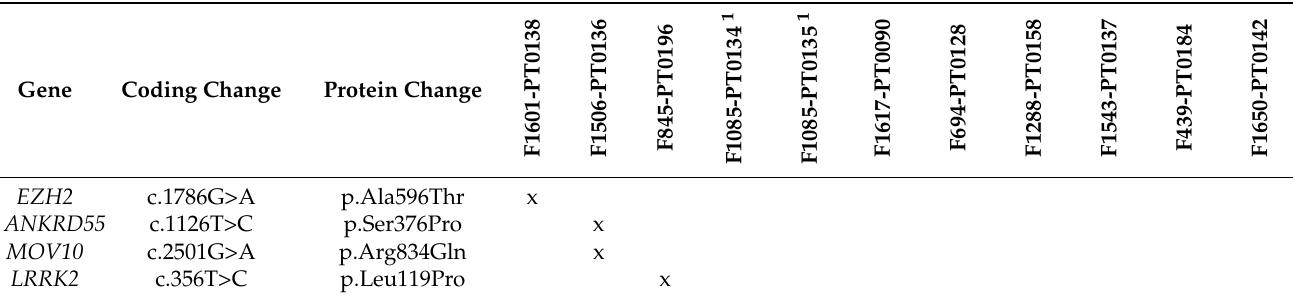
Table 3. FANCI interactome candidate variants identified in FC OC cases negative for pathogenic